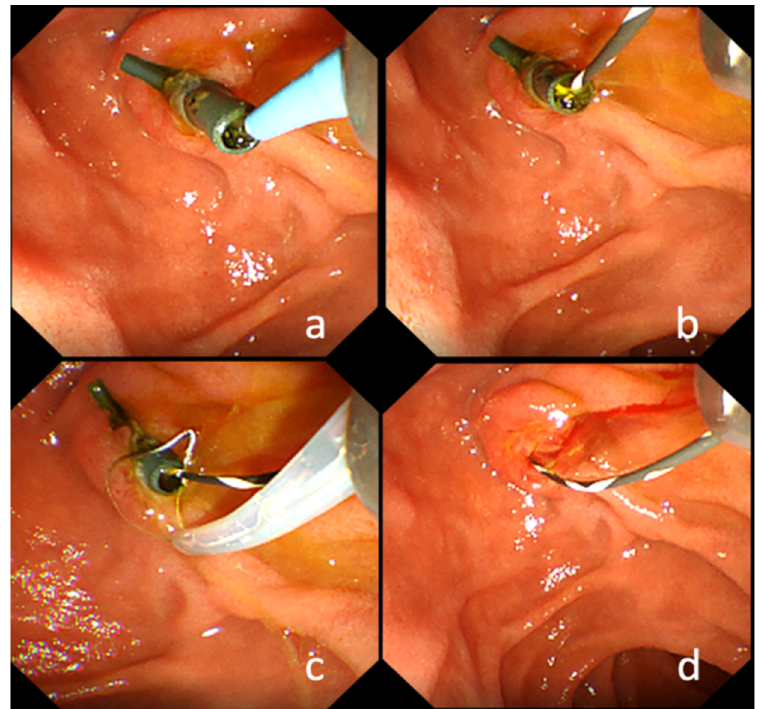
Figure 2. Endoscopic image of the snare-over-the-guidewire method. ( a ). A guidewire was inserted transiently into the drainage area through the lumen of the PS. ( b ). A guidewire passing through the stent lumen is visible. ( c ). The PS was grasped using a snare inserted through the guidewire. ( d ). The PS was removed using a snare while leaving the guidewire.